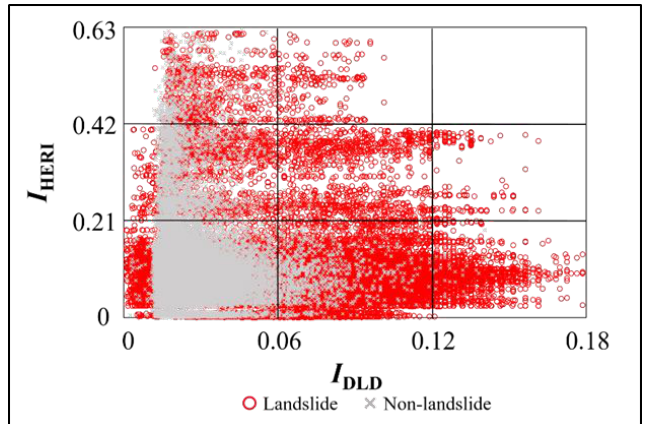
Figure 5. Relationships among the I HERI , I DLD , and landslide occurrence after various rainfall and earthquake events in the study area.